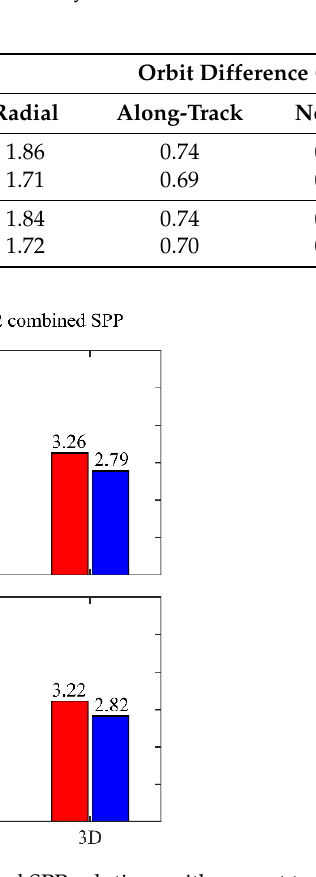
Figure 15. Differences of GPS and GC combined SPP solutions with respect to GPS-based POD when the PDOP values of GPS exceed 3. ( top panel ) is TH-2A and ( bottom panel ) is TH-2B. The contribution of the BDS observations for the combined POD is analyzed in this section. The residuals and overlap comparisons are used to assess the orbit precision. Table 6 shows that the values of the residual RMS of the combined POD are close to those obtained by the GPS- and BDS2-only POD, as listed in Table 2. The overlap comparisons of the GC combined POD are smaller than those of the single BDS- and GPS-based POD. Figure 16 indicates that the daily 3D RMS of the overlap differences of the GC combined POD are less than those of the BDS2-only. The overlap comparisons of the GC combined solutions are on average 0.65 and 0.64 cm (3D RMS) for the TH-2A and TH-2B, respectively. Compared with the GPS-based orbits, the precision of the GC combined solutions is only improved by 3–4% in 3D, which is hampered by the precision of the BDS2 precise orbit and clock products [36]. Table 6. Average RMS of PC and LC residuals of GC combined POD.